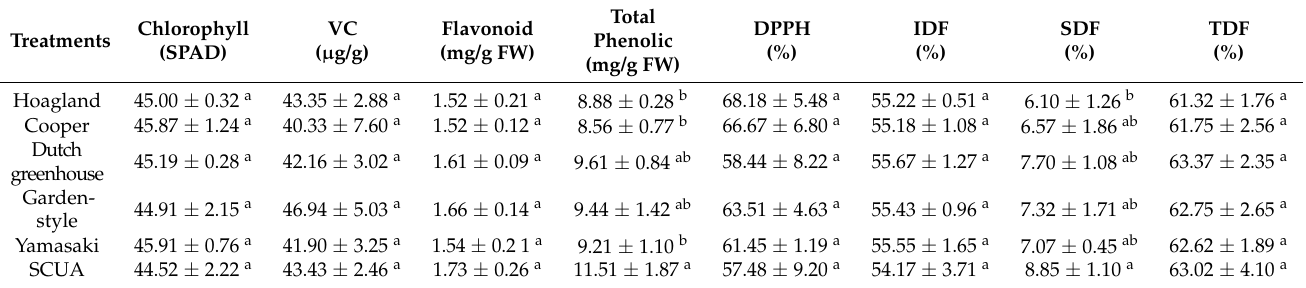
Table 2. The effects of nutrient solution culture with different formulations on the quality characteris- tics of water dropwort.